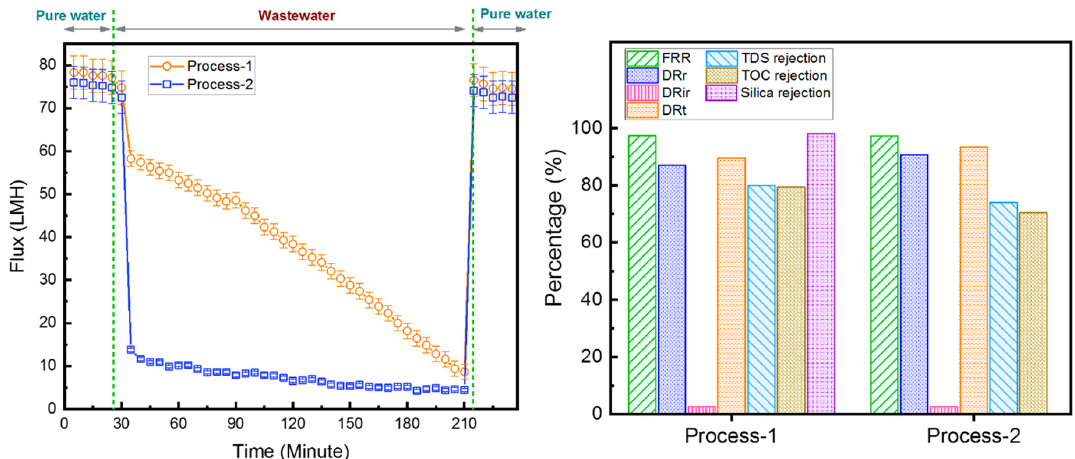
Figure 4. The permeation performance and fouling characteristics of NF tests in processes 1 and 2. Transmembrane pressure is set at 250 psi and operating temperature of 25 °C.